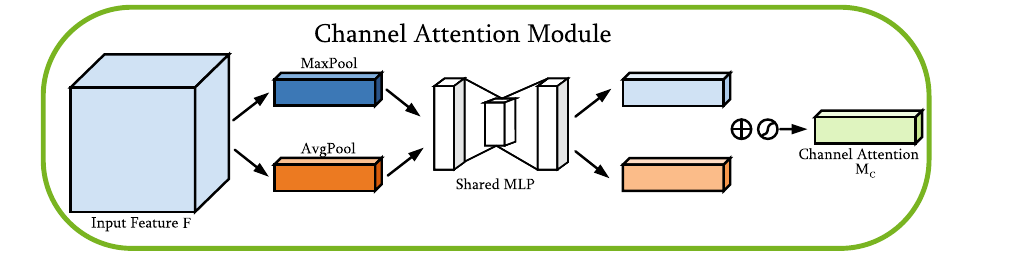
Figure 7. Diagram of channel attention